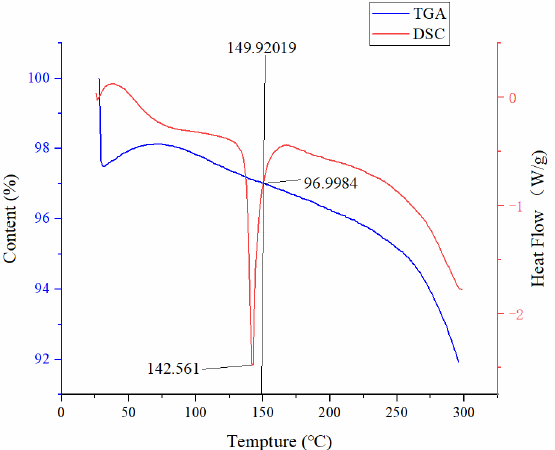
Figure 1. TGA and DSC curves of pure PZQ.